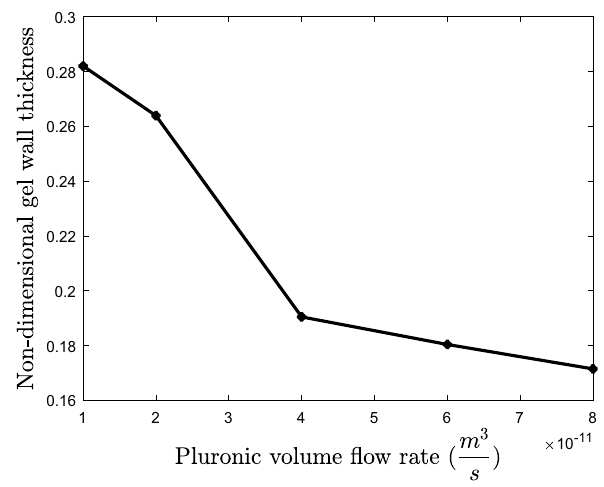
Fig. 11 Changes in gel wall thickness as a function of Pluronic vol- ume flow rate